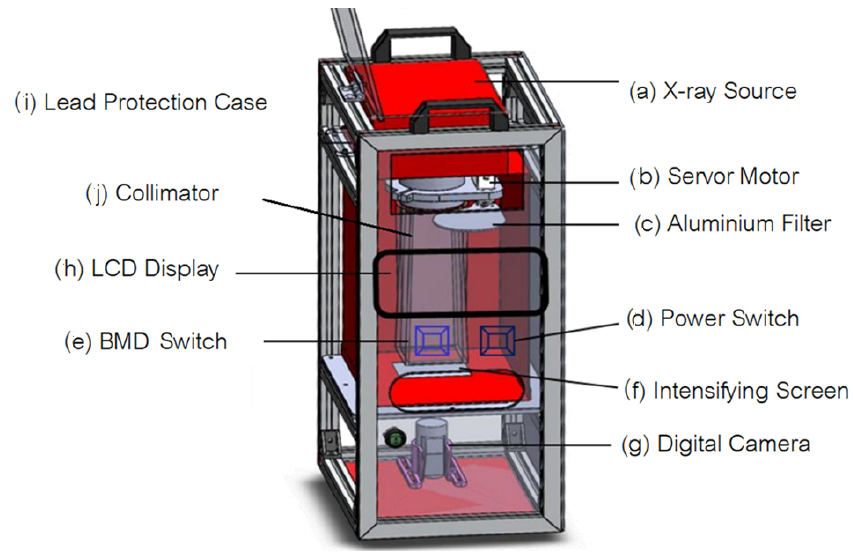
Figure 15. Portable Bone-Mineral Density Measurement System.